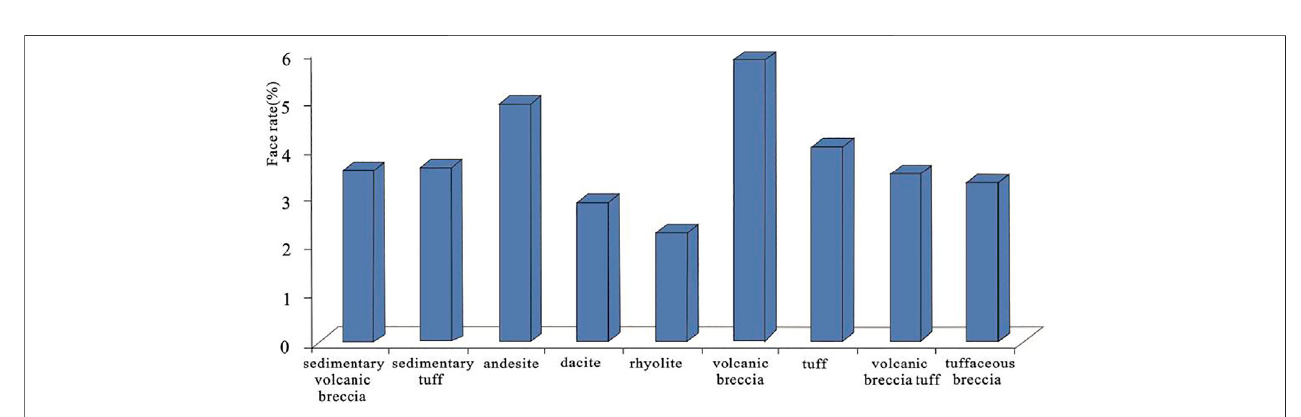
FIGURE 14 | Average face rate of different lithology in the Mesozoic of the D Oil fi eld.